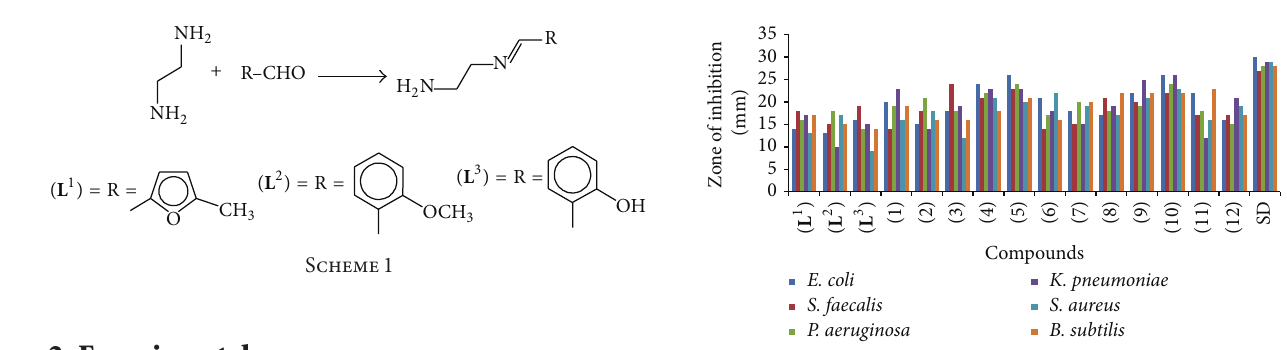
Figure 1: Comparison of antibacterial activity of Schiff bases versus metal(II) complexes.